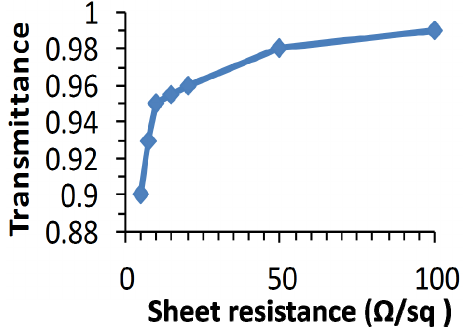
Figure 3. Transmittance as a function of the sheet resistance. This is used to represent TCO induced optical losses in industrially sputtered ZnO: Al material for a wavelength between 400 nm and 1100 nm and do not reflect state of the art laboratory results.